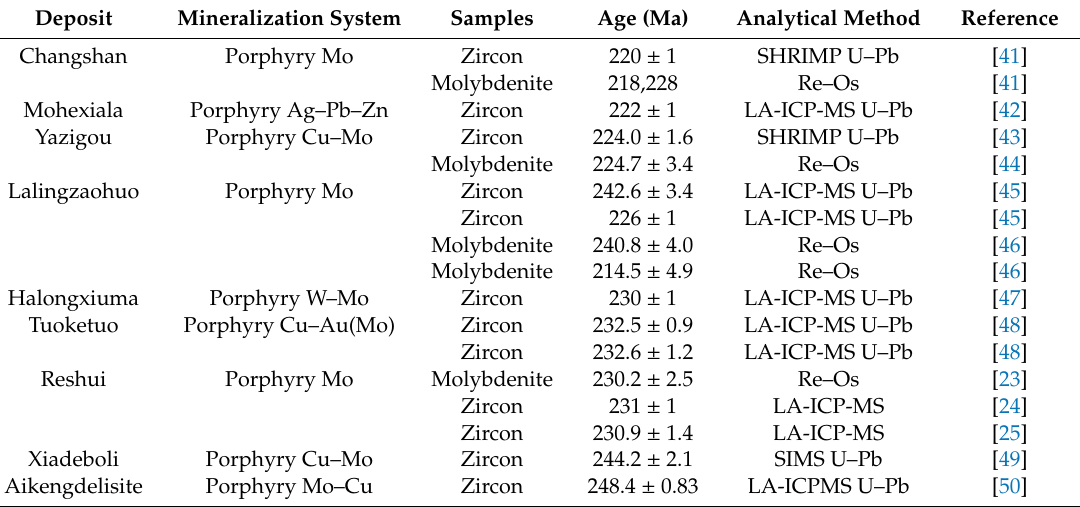
Table 3. Age of porphyry deposits from East